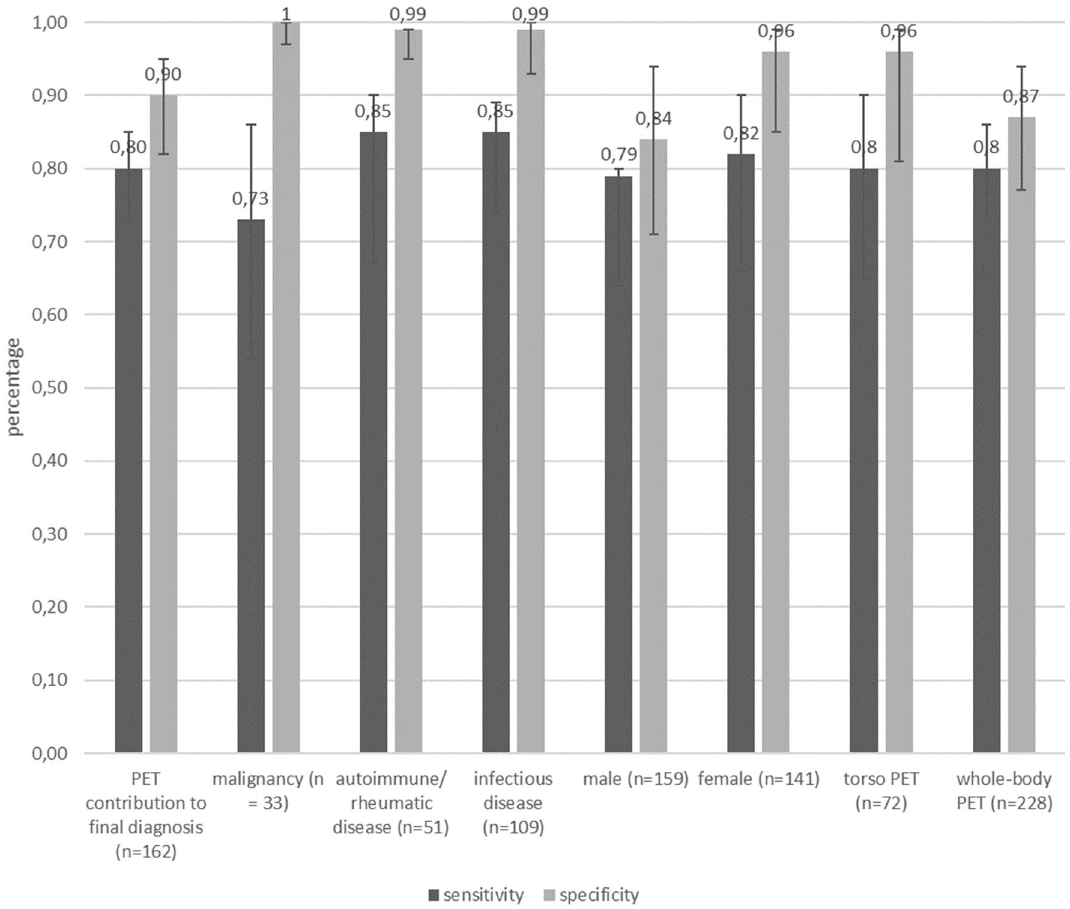
Figure 1. Chart for sensitivity and specificity in study population including 95% Fisher confidence interval. Note the high specificity for malignancy despite a lower sensitivity compared to other